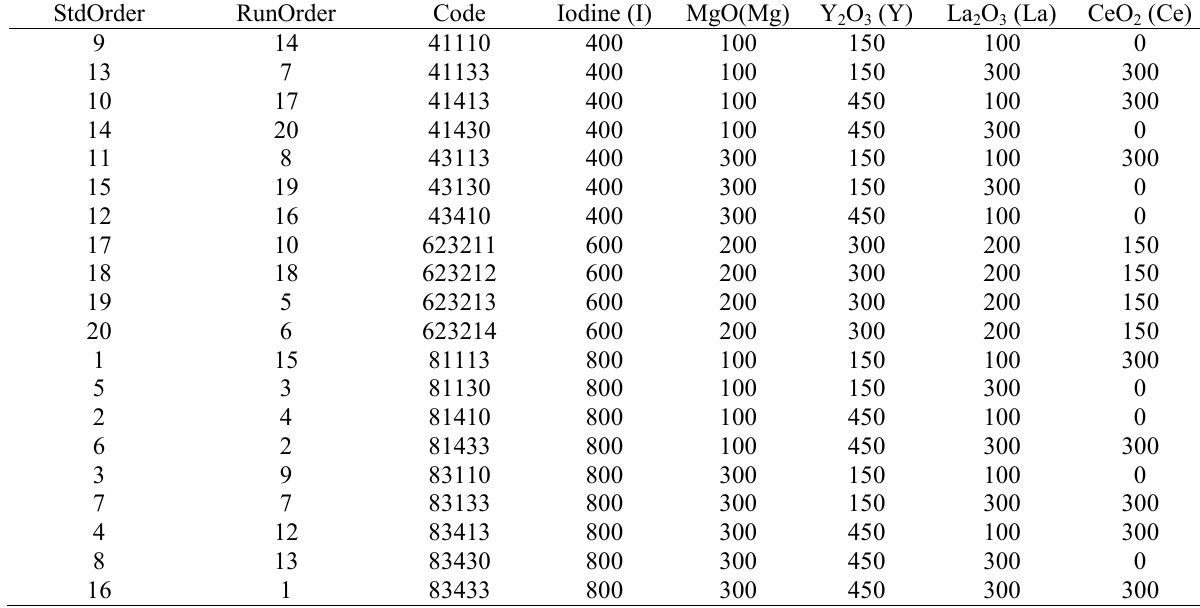
Experimental matrix (according to sample code order)